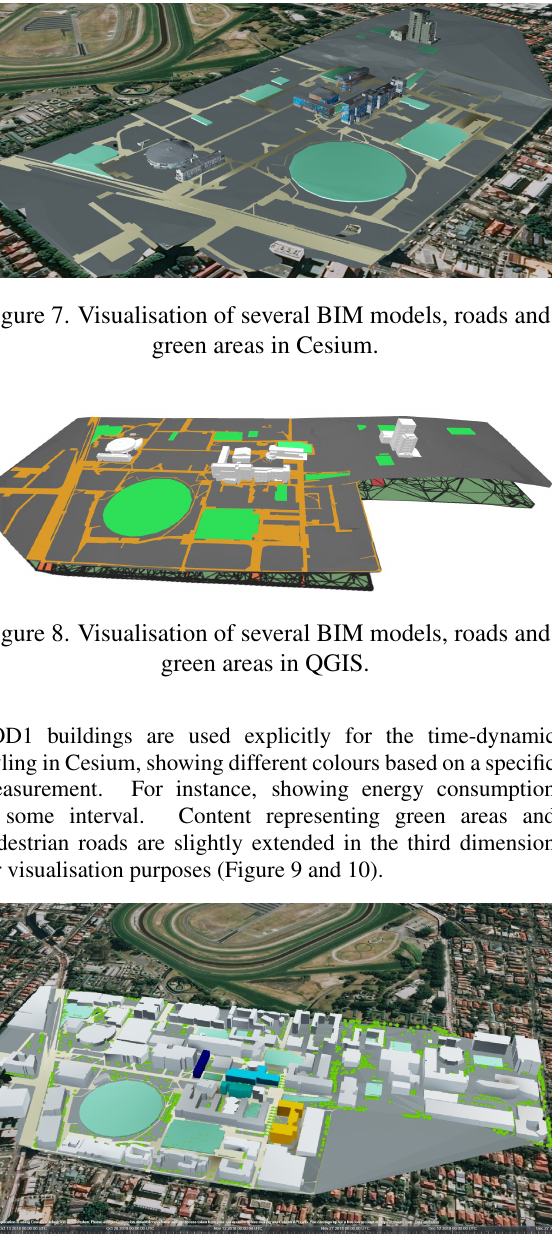
Figure 9. CityGML - LOD1 for buildings, pedestrian roads, green areas and trees in Cesium.